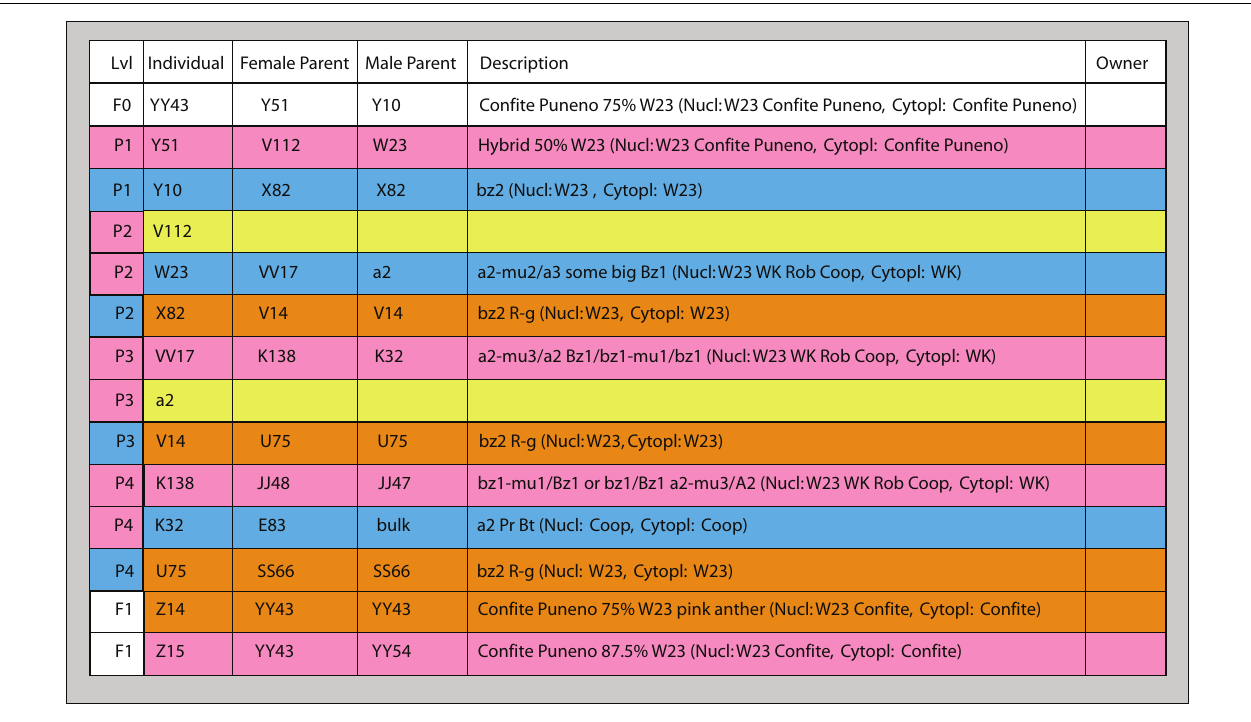
FIGURE 3 | Color-coded table provided with the family tree display. Table of all individuals charted in the family tree for individualYY43. Row color coding matches the boxes in the family tree drawing.